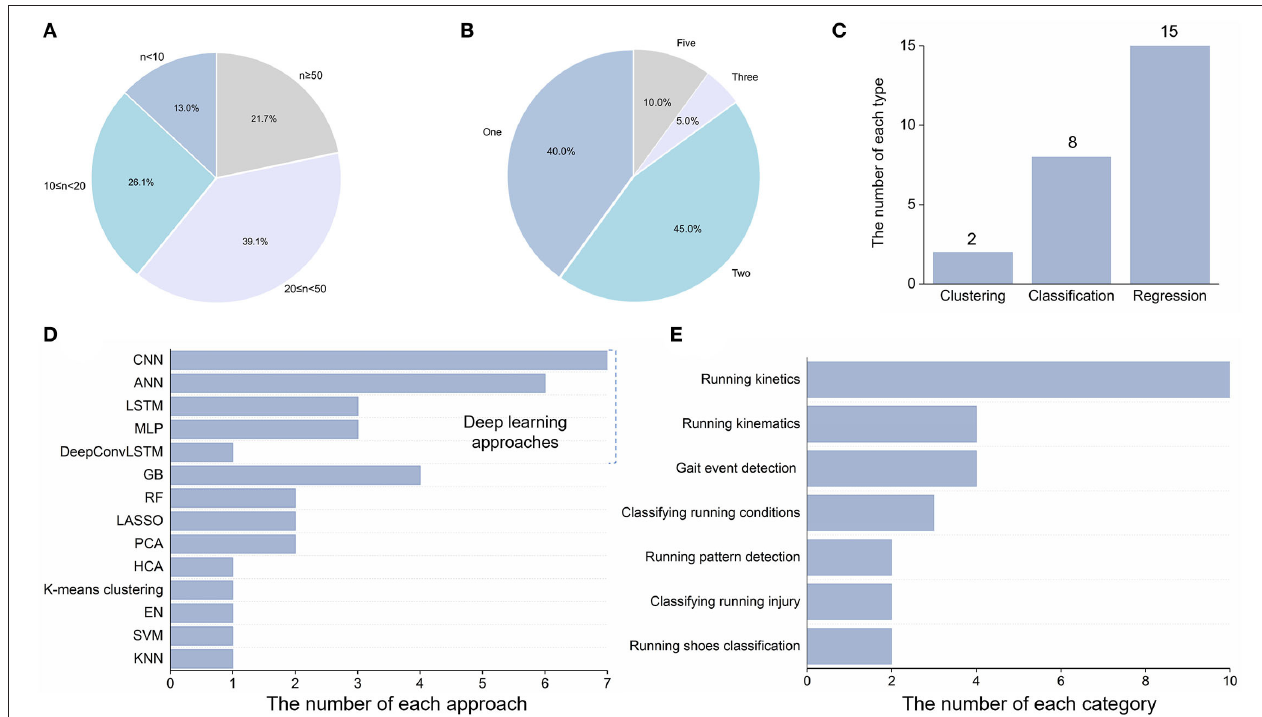
FIGURE 2 | Characteristic information: (A) sample size; (B) the number of sensors; (C) types of machine learning algorithms; (D) machine learning approaches; (E) purpose of machine learning.